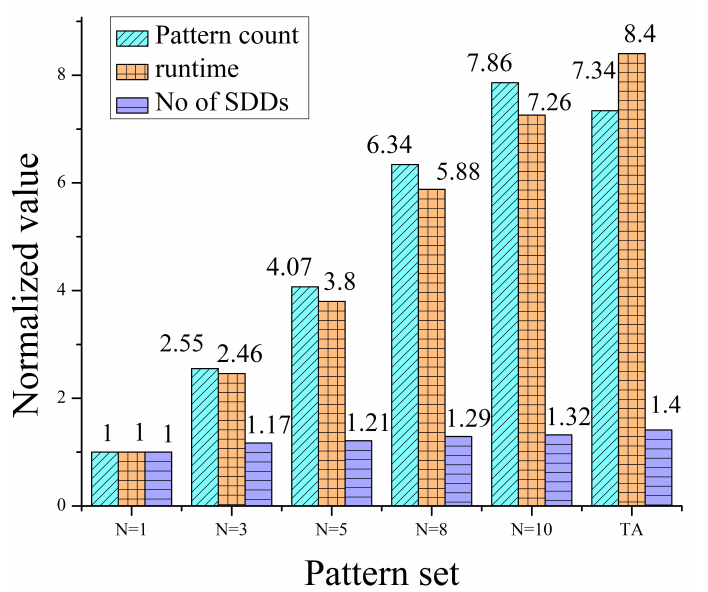
Figure 6. Comparison of normalized values of SDDs detected, pattern count, CPU runtime of various N-detect and TA pattern (Usb_function benchmark)